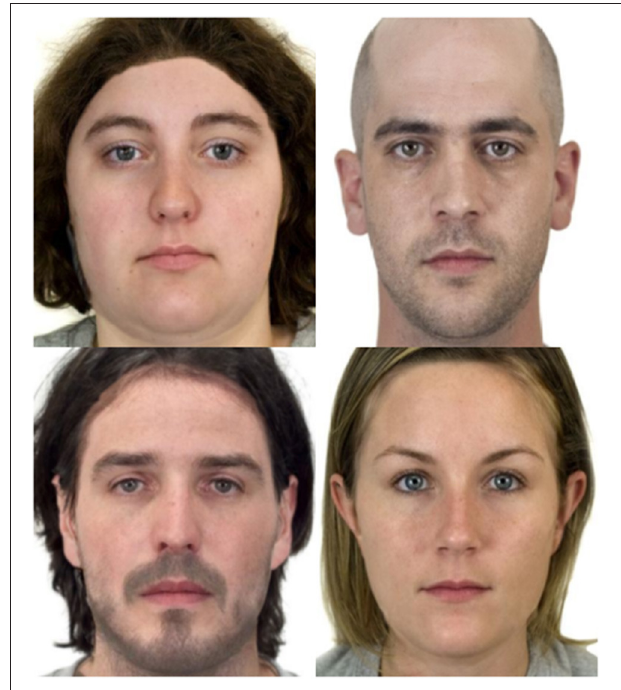
FIGURE 5 | Examples of transformed stim rated for dominance (top) and trustworthiness (bottom). Left column depicts transforms rated low in the trait. Right column depicts transforms depicted high in the